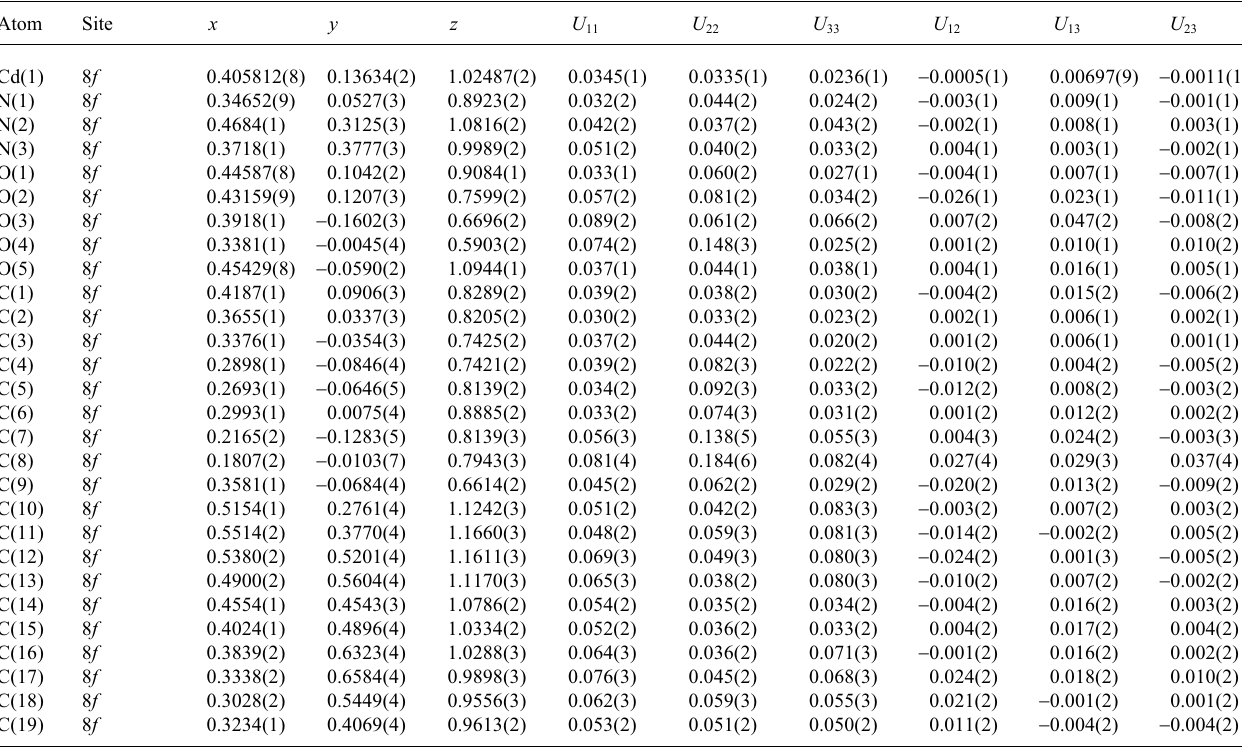
Table 3. Atomic coordinates and displacement parameters (in Å 2 )